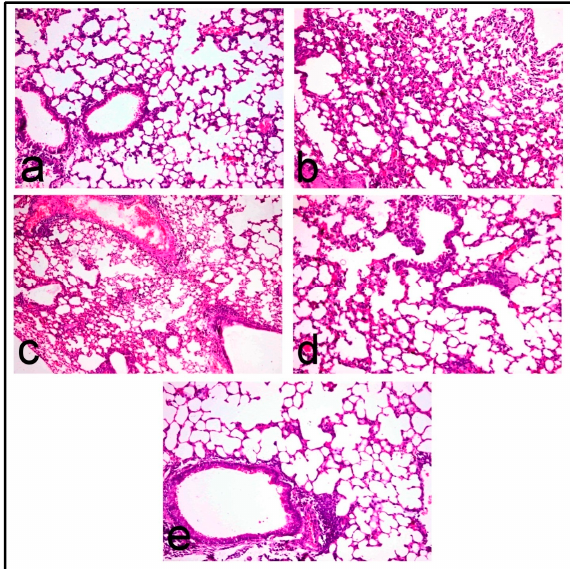
Figure 3. Histopathological images of BLM-induced lung fibrosis in mice; Lung of ( a ) control mice showing normal pulmonary parenchyma; ( b ) BLM-treated mice showing marked thickening of alveolar wall and interstitial tissue by proliferating mononuclear cells mostly lymphocytes and macrophages and fibroblastic proliferation; ( c ) PRO-25 treated mice showing interstitial inflammatory cell infiltrates; ( d ) PRO-50 treated mice showing less distorted pulmonary parenchyma with mild interstitial inflammatory cell infiltration, and ( e ) PRO-100 treated mice showing normal pulmonary parenchyma. (H&E, 200×).